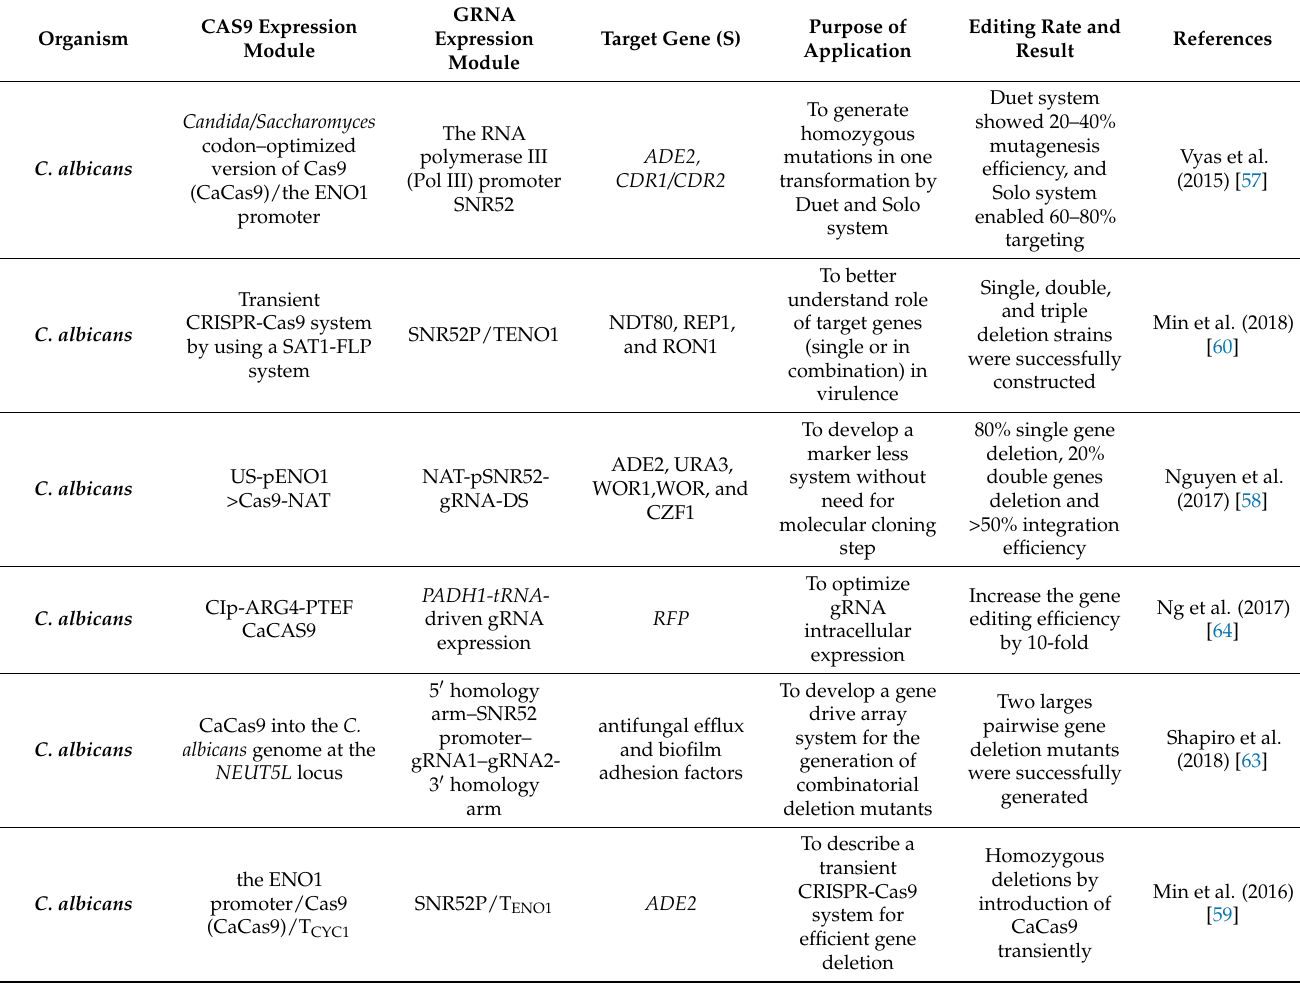
Table 1. Modules, applications and success rate of the CRISPR/Cas9 system in manipulating clinically relevant yeasts.